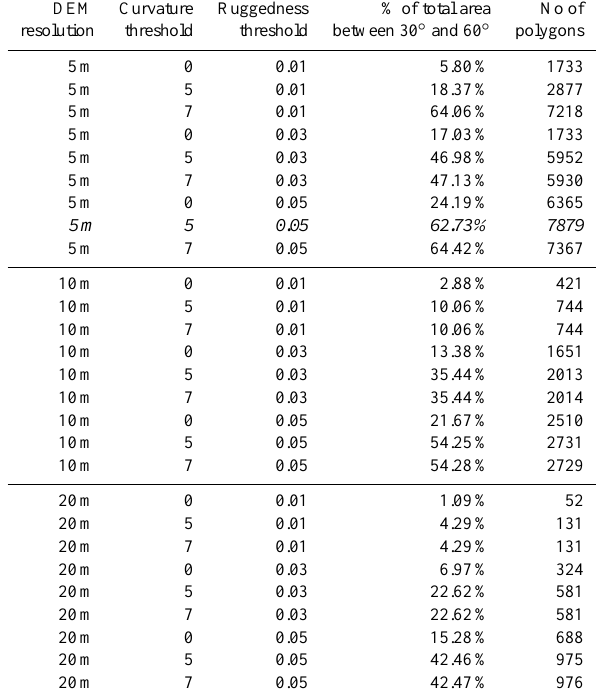
Table 2. Calculated parameter settings to find the optimal trade-off between mapping only as much area as necessary without missing many avalanche release zones for the test site Manali. The selected parameter set is marked in